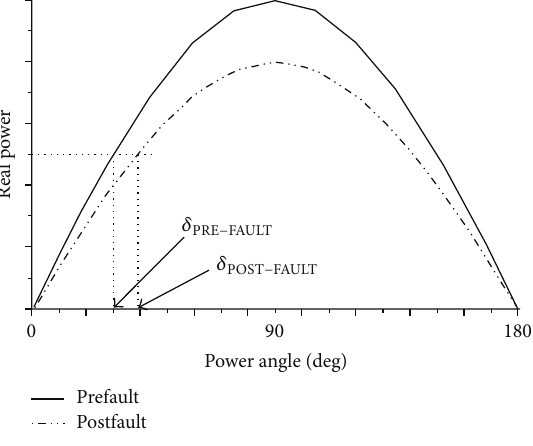
Figure 3: Thevenin equivalent circuit illustrating the fault process: (a) prefault operation and (b) postfault operation. Figure 4: Power transfer between two